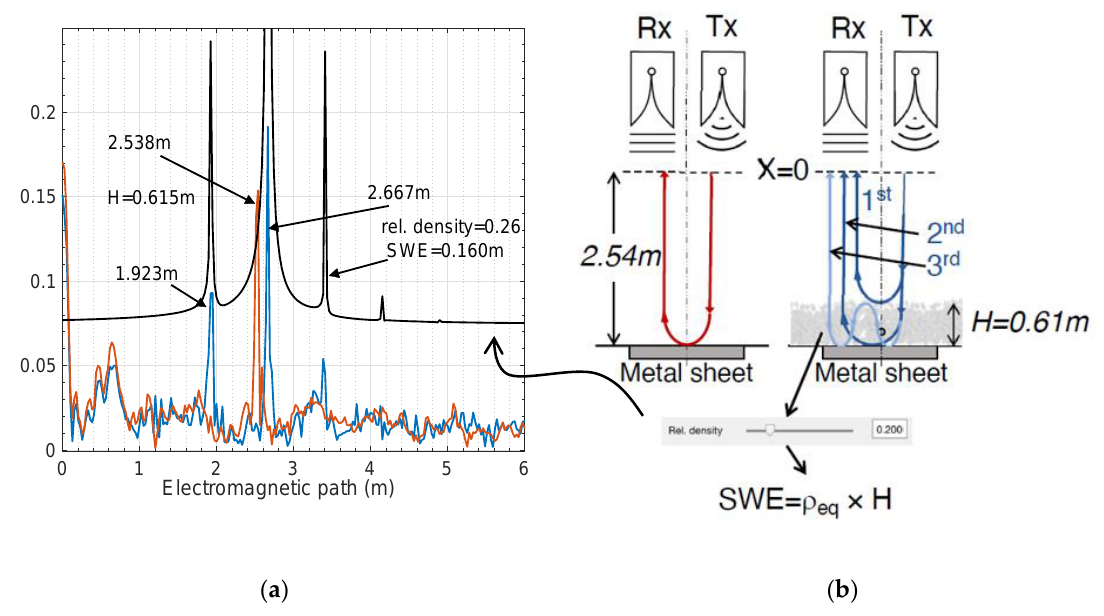
Figure 13. ( a ) Comparison of the experimental spatial reflectance obtained for a snow layer 61 cm deep and the one simulated by the matrix model. ( b ) Outline of the model adjustment procedure with the experimental curve using the density slider of the visual program.